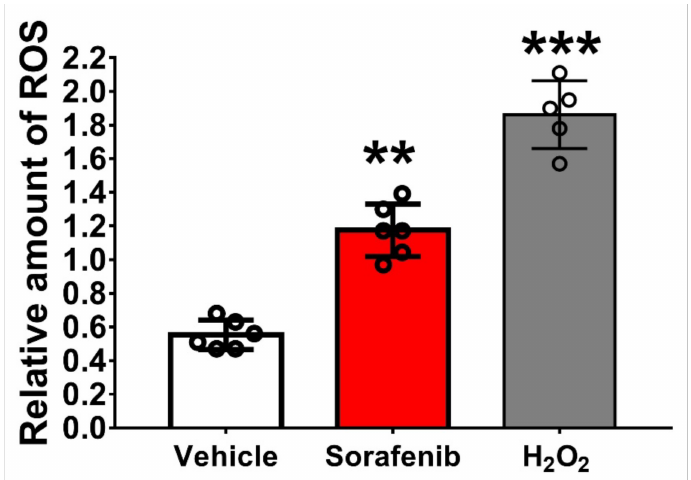
Figure 4. The quantification of ROS generated in sorafenib-treated hiPSC-CMs. Mitochondria- damage-induced reactive oxygen species (ROS) production can be detected in both sorafenib-treated hiPSC-CMs. The imbalance between mitochondrial reactive oxygen species overexpression and removal leads to oxidative damage affecting cellular components. Since the cardiomyocyte is a highly energetic organ, it is vulnerable to damage caused by oxidative stress. p -values, ** p < 0.01, *** p < 0.001, compared with vehicle.